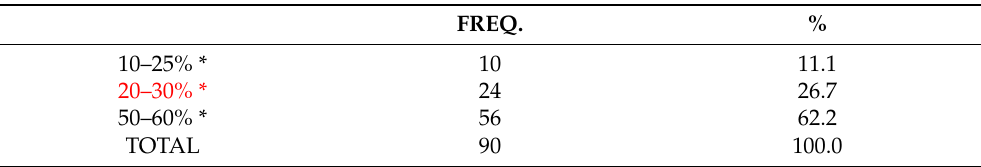
Table 1. Percentage of responses about the global prevalence of untreated caries (correct answer red